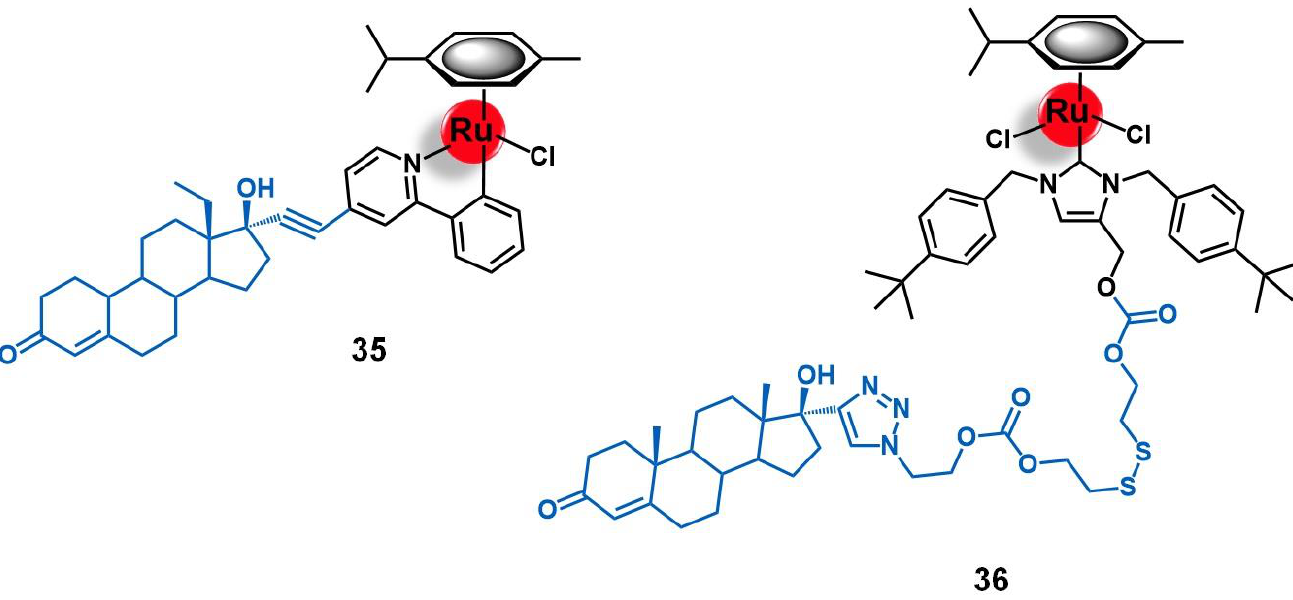
Figure 12. Ru(II)-conjugates that target the progesterone receptor (PR): 35 contains the steroid levonorgestrel as vector, while the tumor microenvironment-responsive 36 is the result of the conjugation of [ Ru(η 6 - p -cym)(NHC)Cl 2 ] complex to a testosterone-derived delivery agent through a glutathione-sensitive linker.